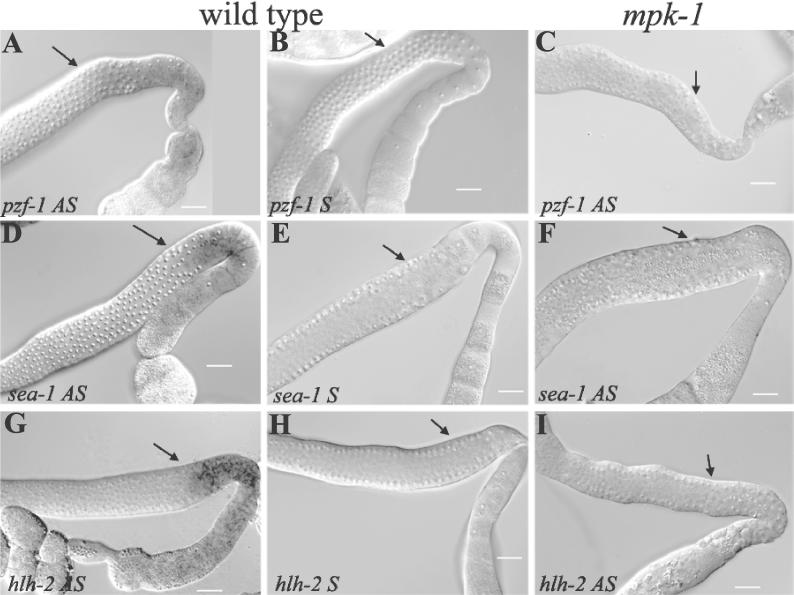
Candidate MPK-1 Signaling-Responsive Autosomal Genes Depend on mpk-1 for ExpressionRNA in situ hybridizations of N2 (A, B, D, E, G, and H) and mpk-1 (C, F, and I) gonads. Sense and AS probes correspond to three MPK-1 signaling-responsive genes on autosomes: pzf-1 (A–C), sea-1/tbx-18 (D–F), and hlh-2 (G–I). Only medial and proximal arm of gonads are shown; no staining was detected in the distal gonad for any probe. Arrow indicates location of late pachytene region. Scale bar, 20 μm.